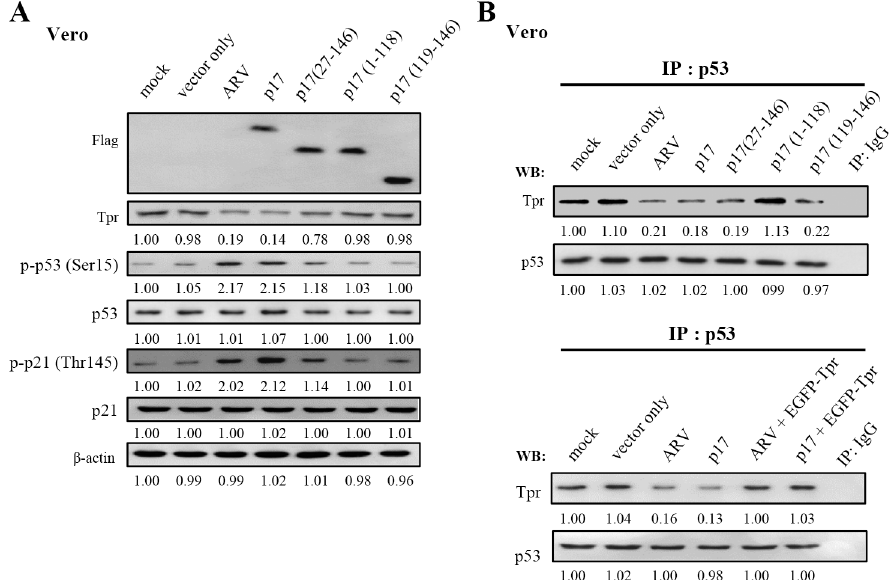
Fig 5. p17 specifically interacts with Tpr and blocks p53 binding to Tpr. (A) To study whether p17 and p17 mutants can downregulate Tpr expression, the levels of Tpr, p-p53, p-p21 were examined in mock- infected and ARV-infected cells as well as in pcDNA3.1-p17-, pcDNA3.1- (vector only), and p17 mutants- transfected cells. Tricine-SDS-PAGE for separating proteins in the low mass range was used. After transfection of the p17 gene and the truncated version of p17 into vero cells for 24 hours, all these proteins were separated by Tricine-SDS-PAGE, followed by Western blot assay with the anti-Flag antibody. (B) Upper panel: to examine whether p17 and p17 mutants affect the binding of p53 to Tpr, the amount of p53 and Tpr association in mock (Vero cells only), ARV-infection, pcDNA3.1-p17- and p17 mutants-transfection were examined. Lower panel: To carry out a rescue assay, cells were transfected with the indicated plasmids or infected with ARV for 24 hours. About 500 ug of cellular proteins was incubated with 4 ug of anti-p53 antibody at 4°C overnight. The immunoprecipitated proteins were separated by SDS-PAGE followed by Western blotting, and then proteins were detected with Tpr or p53 antibody, respectively. The protein levels were normalized to those for β -actin. Results were obtained from three independent experiments. The activation and inactivation folds indicated below each lane were normalized against those at mock controls. The levels of indicated proteins at the mock control were considered